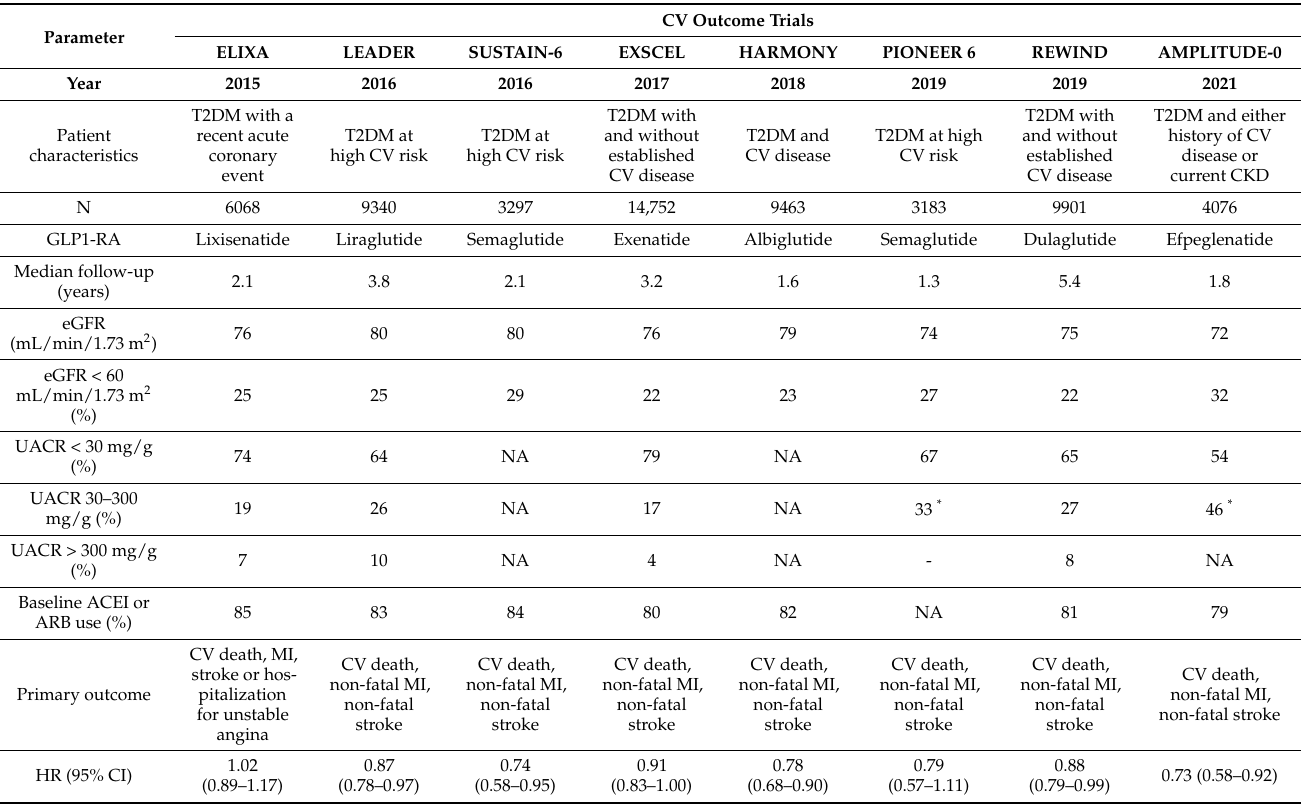
Table 2. Summary of major randomized trials exploring the effect of GLP-1 receptor agonists on cardiovascular